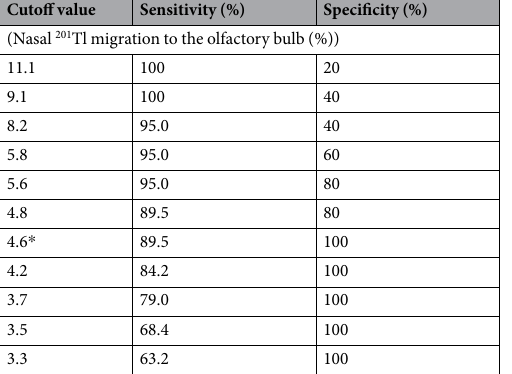
Table 3. Sensitivity and specificity at the cutoff values of nasal 201 Tl migration to the olfactory bulb between patient groups with and without recovery at 6 months after olfacto-scintigraphy. * Optimal cutoff